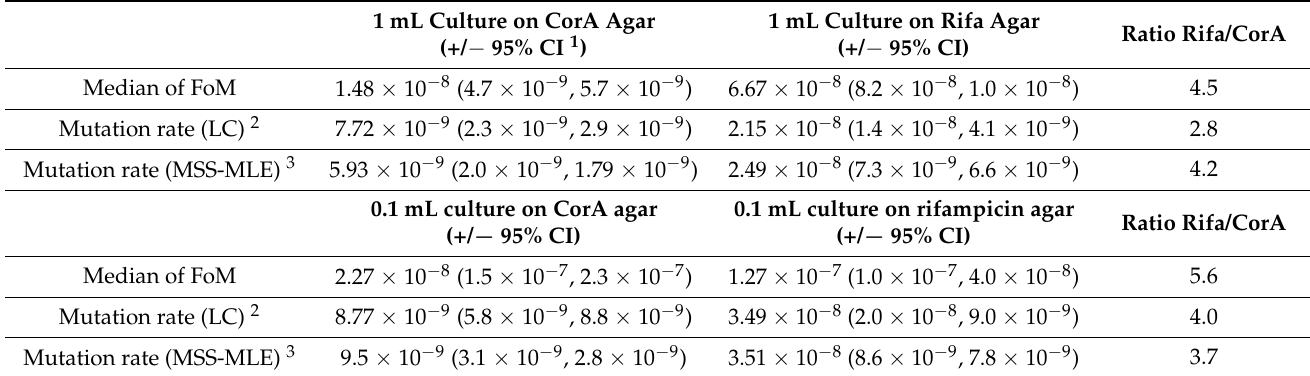
Table 2. Frequency of mutations (FoM) leading to resistance and mutation rates of S. aureus selected on 4 × MIC CorA or rifampicin using 1 mL or 0.1 mL of culture and two different methods (LC and MSS-MLE) for the calculation of the mutation